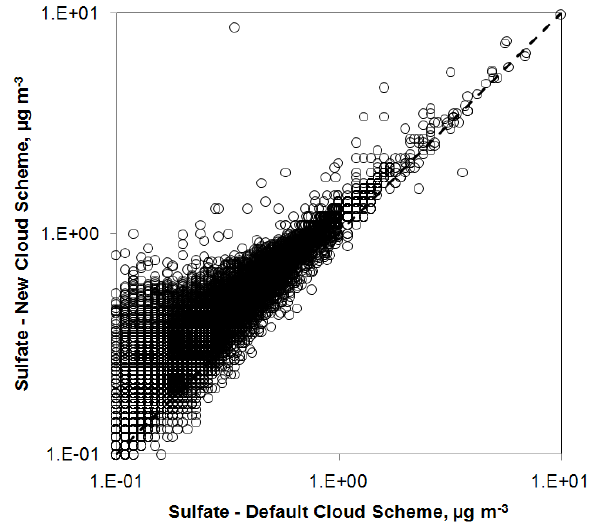
Figure 1. Comparison of CMAQ hourly sulfate aerosol mass concentrations in the surface layer using the revised (with S org chemistry turned off) and default (original) cloud chemistry models. The new cloud model produces lower values for some of the higher original cases and higher values for most of the lower original cases. Model differences are a result of differences in the treatment of gaseous reactant uptake by cloud droplets and the timing of cloud and gas-phase chemistry.